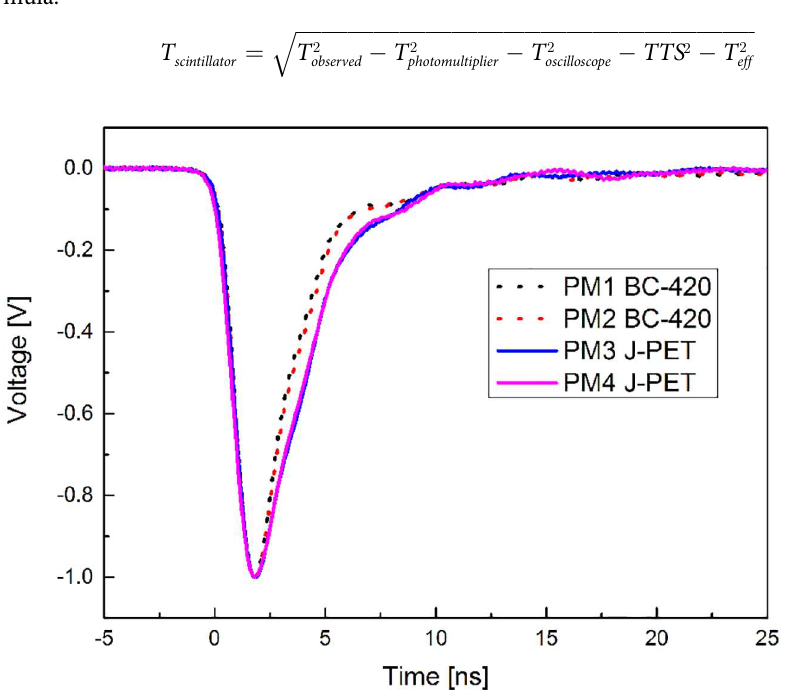
Fig 9. Average signals measuredwith detectors consisting of the BC-420or the J-PET scintillators and Hamamatsu R9800photomultiplier. The shownshapes result from averaging of 10 5 signalsusing method describedin references [17]. Signals were normalizedto the amplitudeequal to